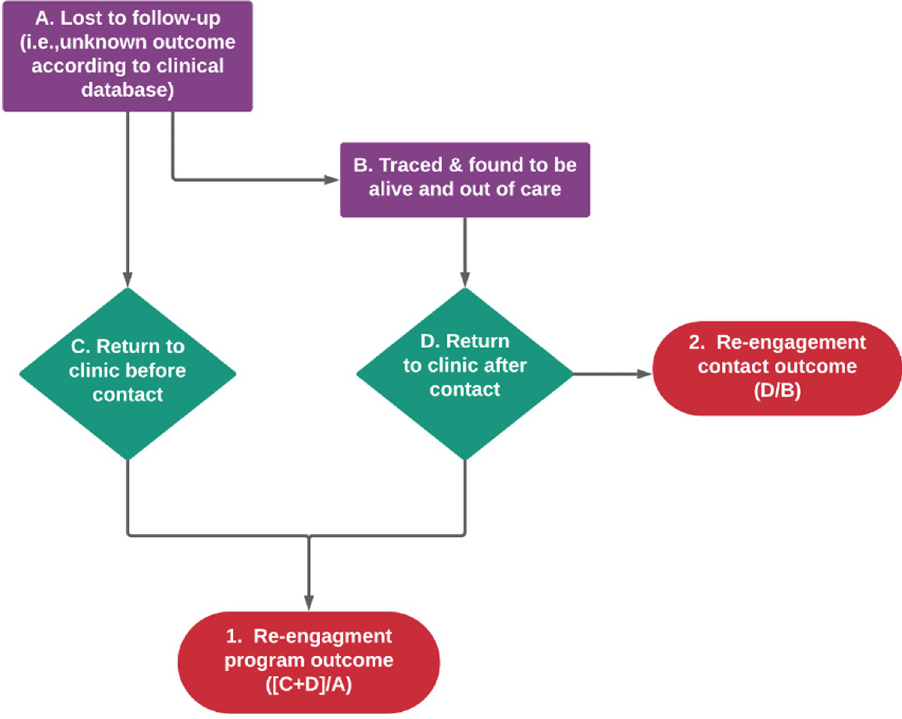
Fig 1. Flow diagram depicting reengagement outcomes: (1) reengagement program outcome; and (2) reengagement contact outcome.